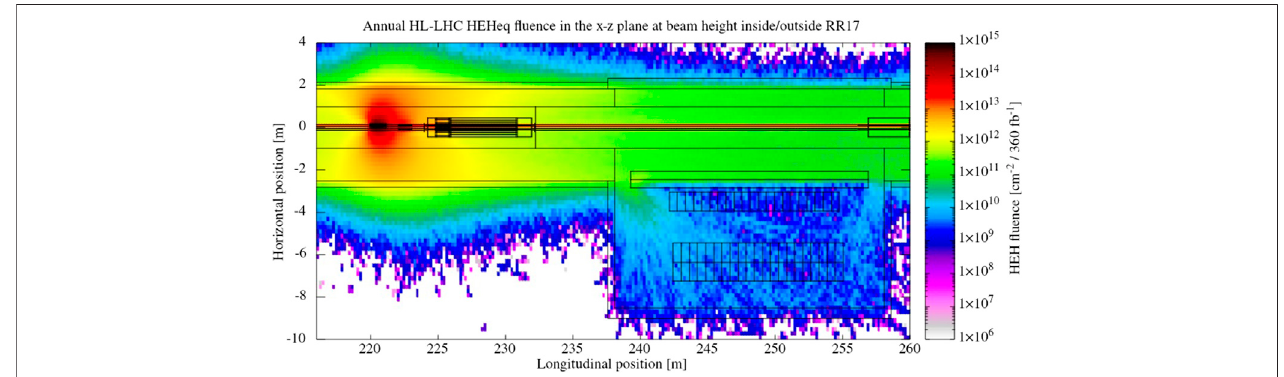
FIGURE 9 | Top view of the annual High Energy Hadron-equivalent fl uence at beam height in a portion of the LHC Long Straight Section at Point 1, showing the main tunnel and the nearby RR17 alcove where electronic equipment is hosted.